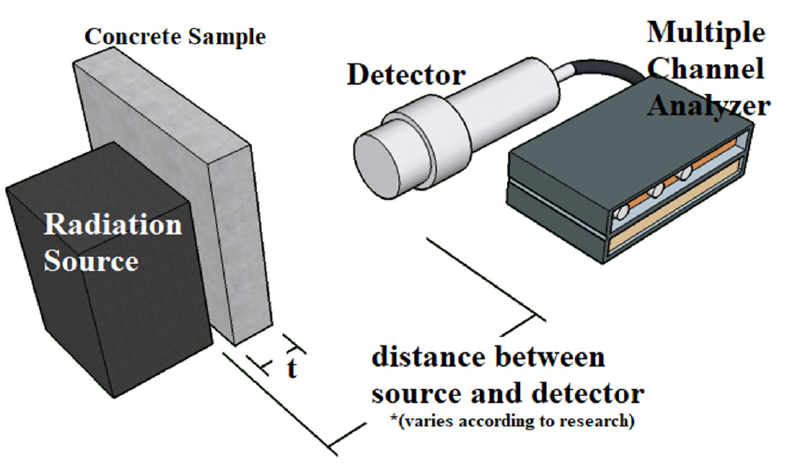
Figure 5. Common linear attenuation coefficient test setup.